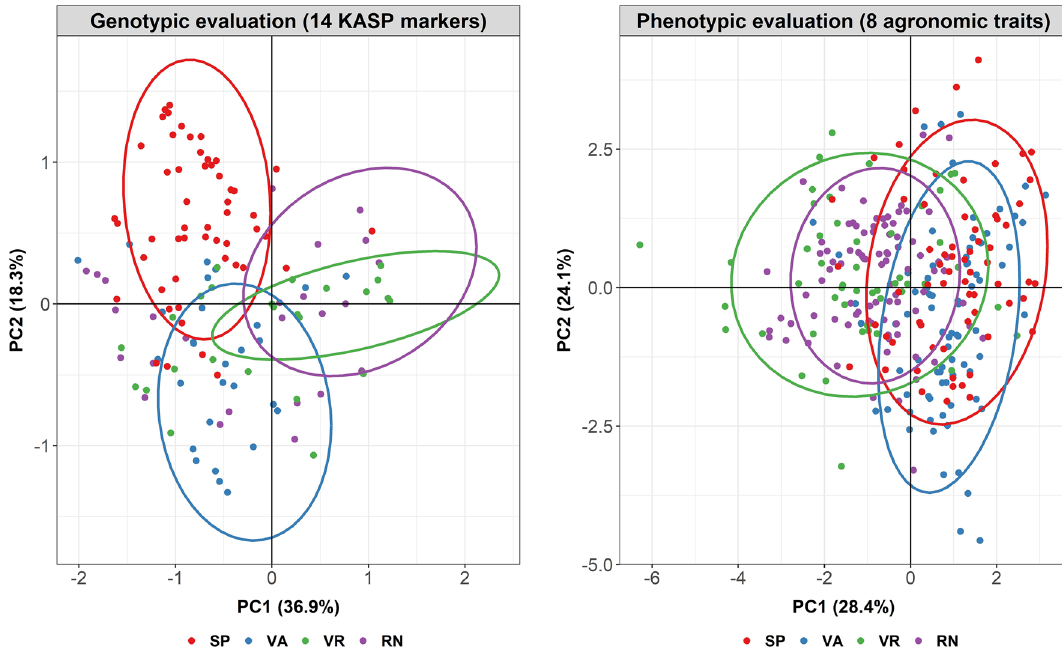
Figure 4. Principal component analysis (PCA) of 282 accessions based on genotyping data of 14 kompetitive allele-specific PCR (KASP) and phenotypic data. 282 accessions were visualized by 4 market types, Spanish (SP), Valencia (VA), Virginia (VR), Runner